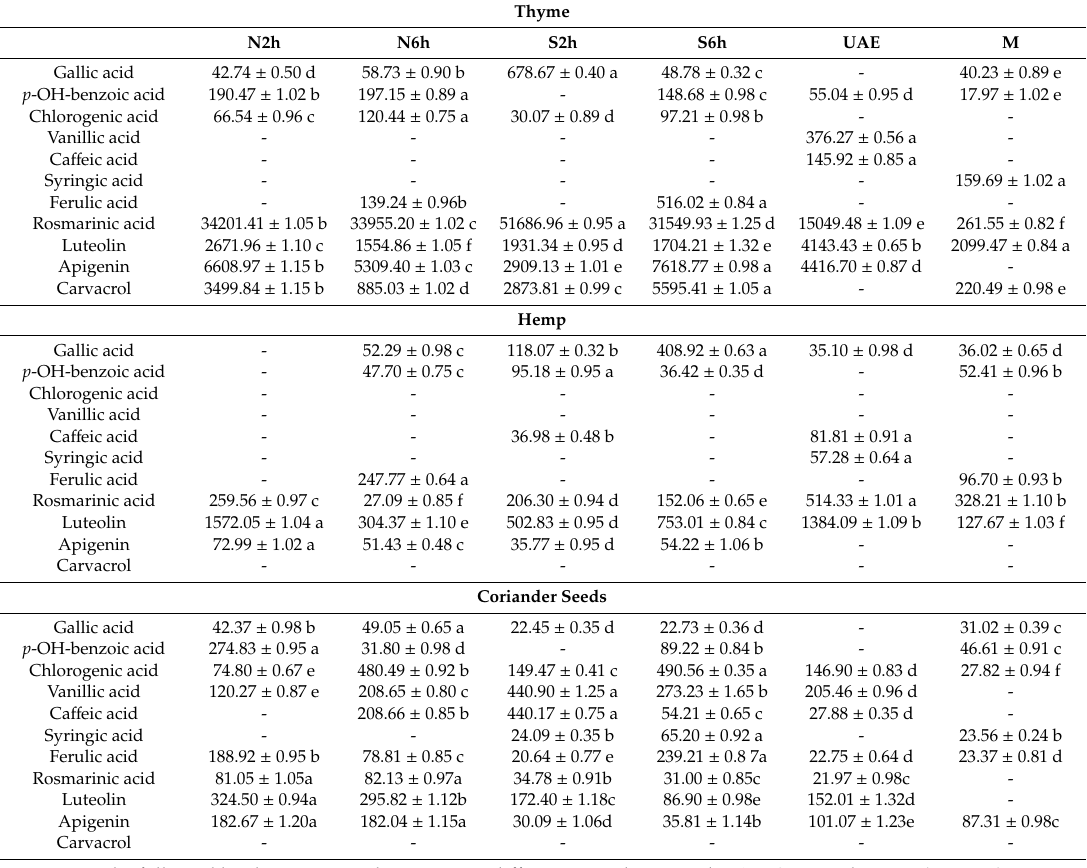
Table 3. Contents of phenolic compounds ( µ g / g dry